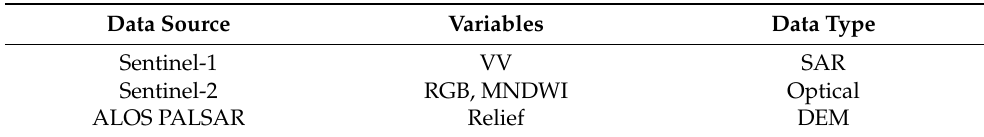
Table 1. Input variables derived for training and driving deep learning networks, including the Sentinel-1 vertical-vertical (VV) dual polarization SAR data, Sentinel-2 red-green-blue (RGB) and MNDWI variables, and the Relief variable derived from the ALSO PALSAR